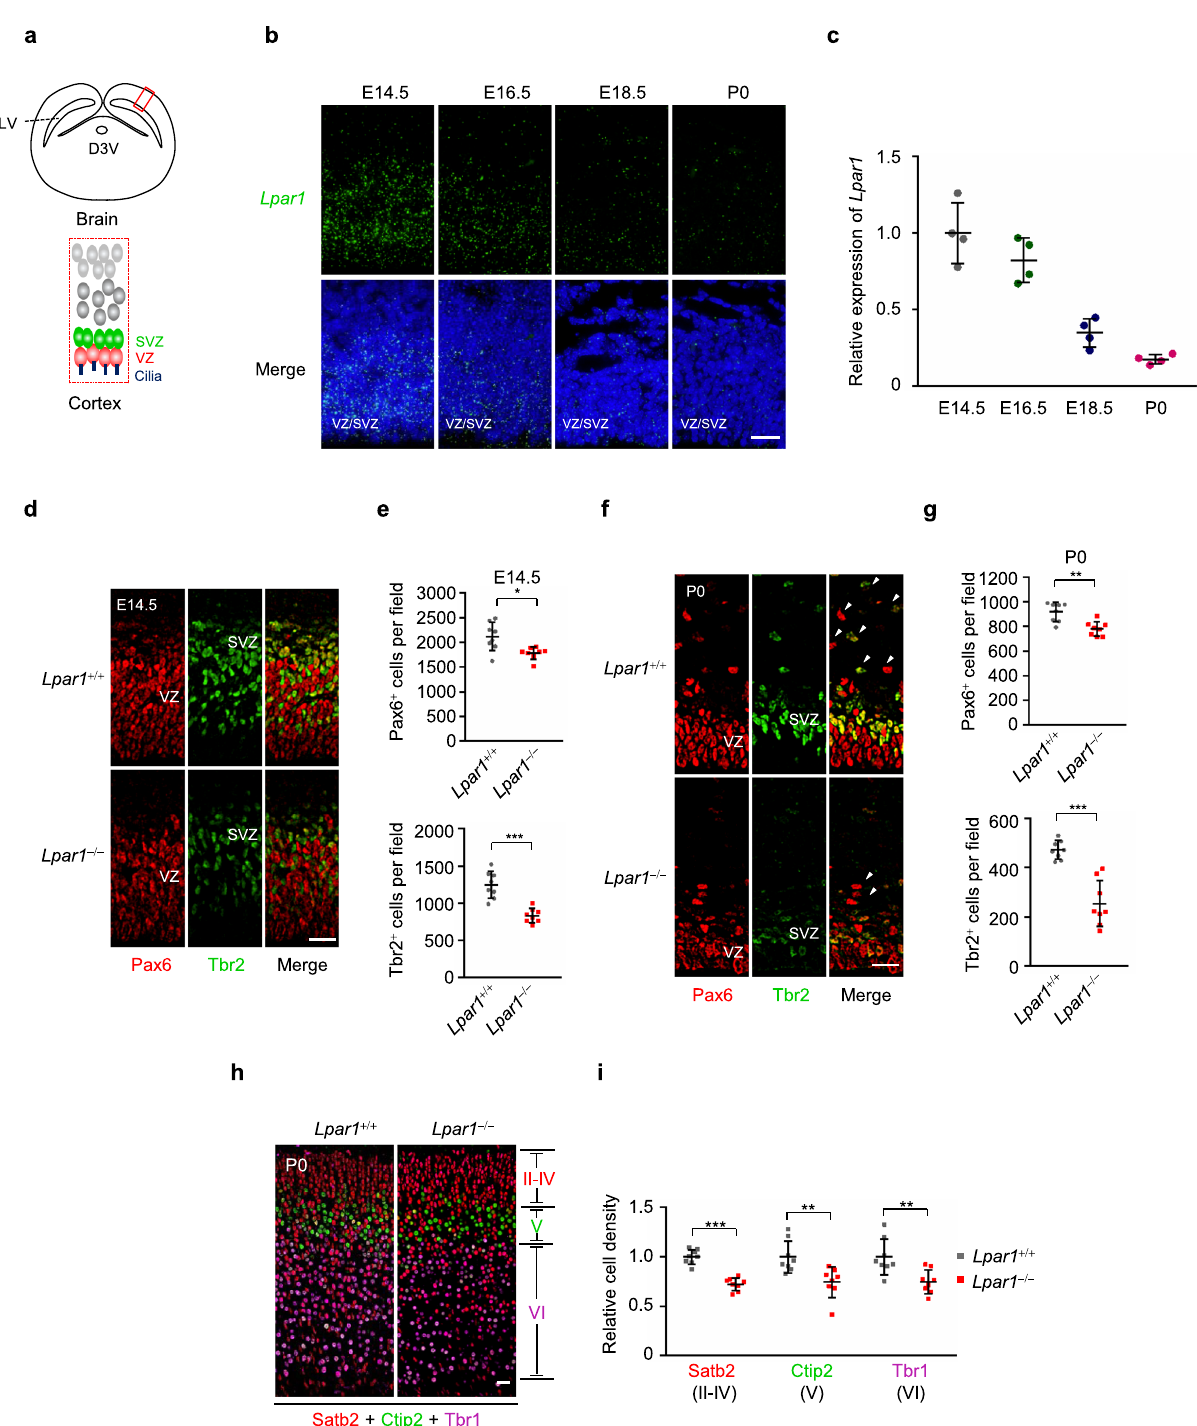
Fig. 5 Lpar1 is required for proper neurogenesis during cortical development. a Schematic diagram of the VZ and SVZ in cerebral cortical. LV, lateral ventricles; D3V, dorsal 3rd ventricle; VZ, ventricular zone; SVZ, subventricular zone. b Expression of Lpar1 in mouse cortex. RNAscope fl uorescent in situ hybridization of Lpar1 in cortex with wide-type mice at E14.5, E16.5, E18.5 and P0, Lpar1 mRNA puncta (green), DNA (blue). Scale bar, 20 μ m. c Quanti fi cation of Lpar1 hybridization signals in b , n = 4 mice. d – g At E14.5 and P0, the total numbers of both Pax6 + and Tbr2 + cells are reduced in the Lpar1 − / − than in Lpar1 + / + mice cortex. d , f Representative images of Lpar1 + / + and Lpar1 − / − mice cortices at E14.5 ( d ) and P0 ( f ), which were stained with antibodies against Pax6 (red, radial glia cells marker) and Tbr2 (green, intermediate progenitor cells marker). White arrows indicate the neural progenitor cells (NPCs) expanded to the upper layers of cortex ( f ). Scale bar, 20 μ m. e , g Quanti fi cation of Pax6 + cells and Tbr2 + cells at E14.5 ( e ) and P0 ( g ) cortices respectively, n = 8 sections from four mice. h Lpar1 − / − mice exhibited a reduction of cortical neuron density at P0. Lpar1 + / + and Lpar1 − / − cortices in mice were stained with layer II-IV marker (Satb2, red), layer V marker (Ctip2, green) and layer VI marker (Tbr1, purple). Scale bar, 20 μ m. i Quanti fi cation of the relative cell density in h , n = 8 sections from four mice. Source data are provided as a Source Data fi le. Four experiments were repeated independently with similar results in b , d , f and h . Data are presented as mean ± S.D. in c , e , g , and i . * P < 0.05, ** P < 0.01, *** P < 0.001. Two-tailed Student ’ s t -test. NATURE COMMUNICATIONS| (2021) 12:662 |https://doi.org/10.1038/s41467-021-20986-y|www.nature.com/naturecommunications